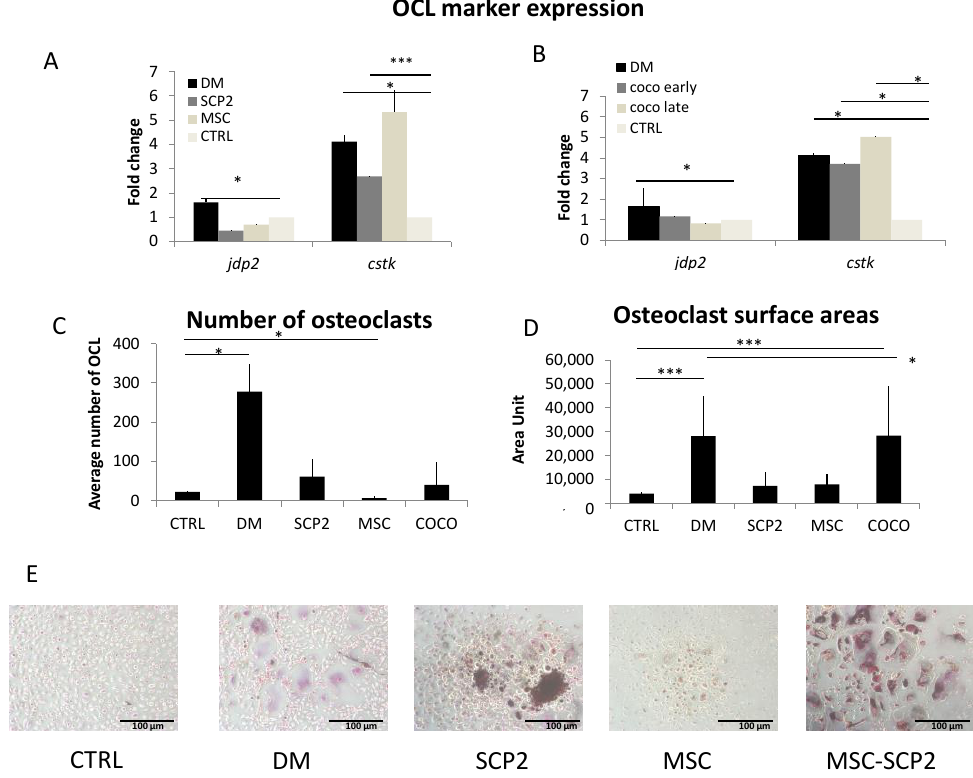
Figure 3. SCP2 and MSC mono-culture and COCO induce osteoclastogenesis. Expression of jdp2 and ctsk in osteoclasts cultured either in DM or in pre-osteoclast medium supplemented with CM from: ( A ) SCP2 or MSC monoculture; ( B ) SCP2-MSC COCO after 24 h (Early-CM) or 72 h (Late-CM) of COCO. qPCR data refer to RNA from pre-osteoclasts. Data were normalized on pre-osteoclasts. t -test was performed comparing the gene expression of the different conditions with the control. * p < 0.05; *** p < 0.01. Average number ( C ) and average surface area ( D ) of TRAP-positive osteoclasts induced by culture in DM, pre-osteoclast medium (CTRL) or pre-osteoclast medium supplemented with SCP2-CM (SCP2), with MSC-CM (MSC) or with CM from SCP2-MSC COCO; t -test was performed for all conditions taking the negative control as control (CTRL). * p < 0.05; *** p < 0.01; ( E ) pictures of osteoclasts on day 14 obtained in the different experimental conditions performed at 10 ×